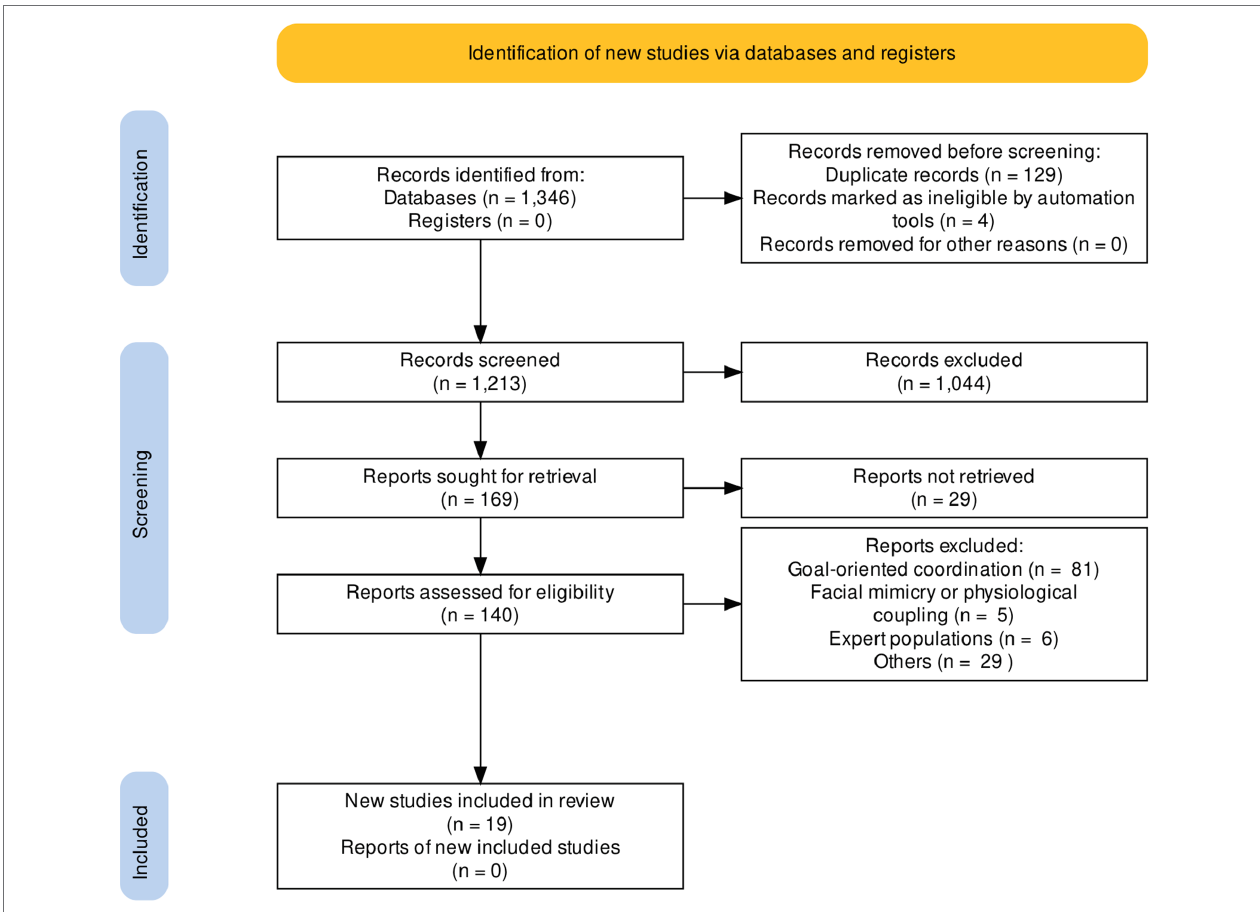
FIGURE 3 | PRISMA flow